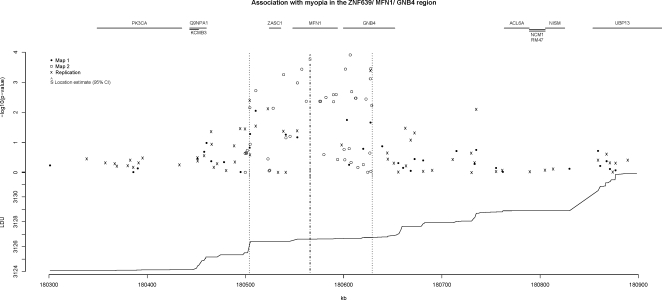
Association with myopia in the ZNF639, MFN1, GNB4 region.Scatter plot of −log10(p-values) for individual markers vs. physical location in kb, with the top of the graph showing gene co-ordinates and the lower graph, cumulative LDU vs. physical location (both graphs on the same kb scale). The vertical dotted lines represent the location parameter estimate, Ŝkb, and 95% confidence intervals. See Figure S1 for pair-wise LD plot of region.